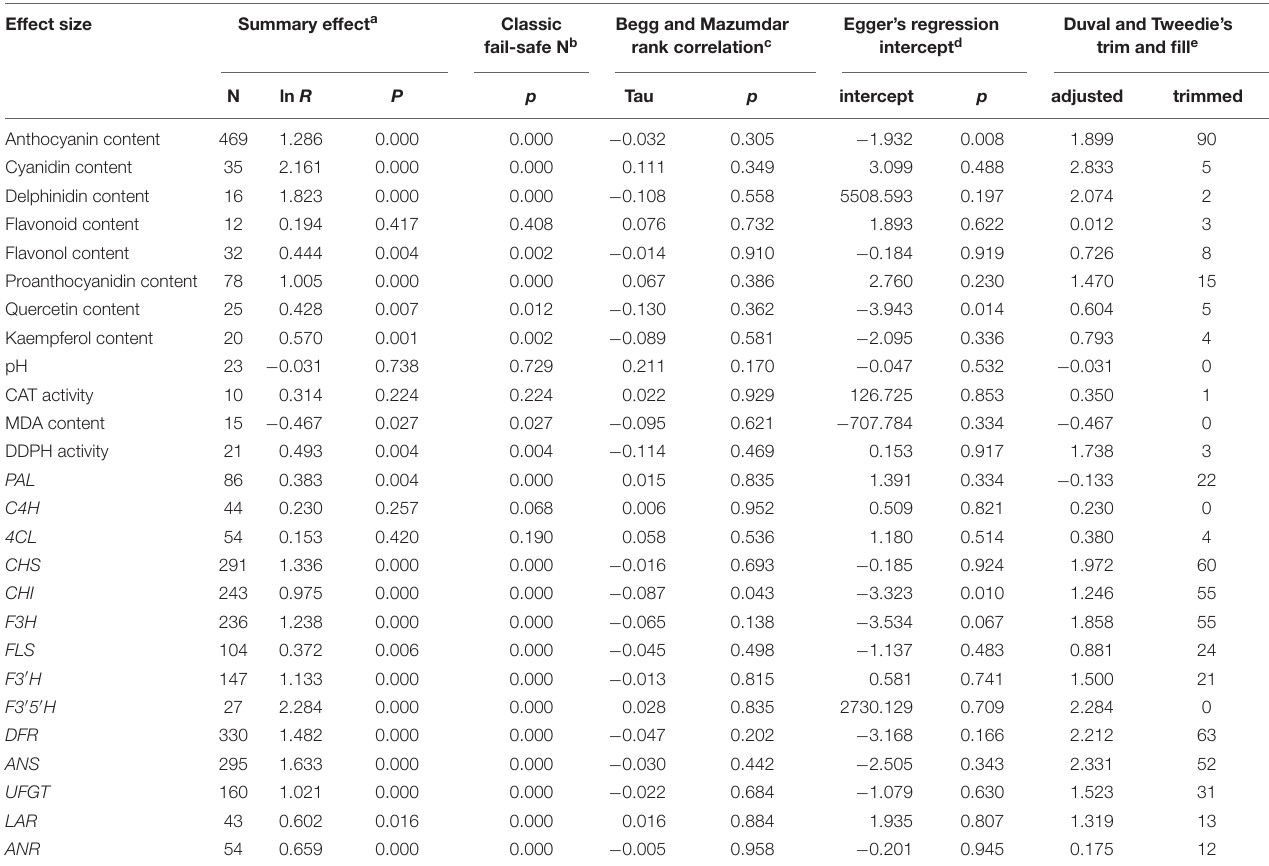
TABLE 1 | Publication bias for all the outcome variables included in this